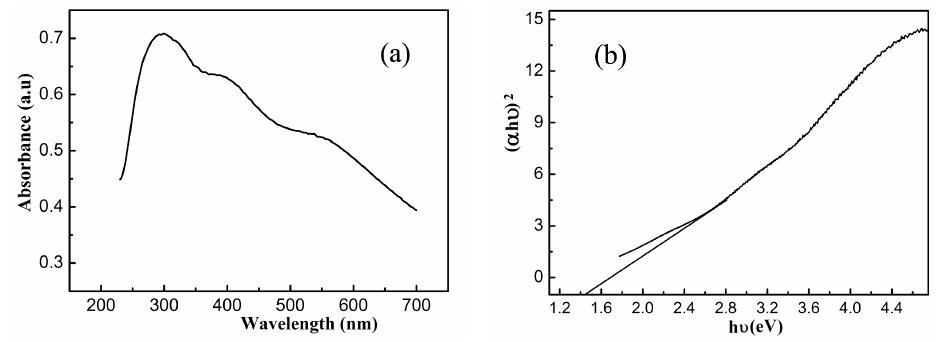
Figure 6. ( a ) UV-vis diffuse reflectance spectrum of the BS-2# sample; and ( b ) the corresponding ( α h ν ) 2 vs. photon energy (h ν ) plots of the BS-2# sample.